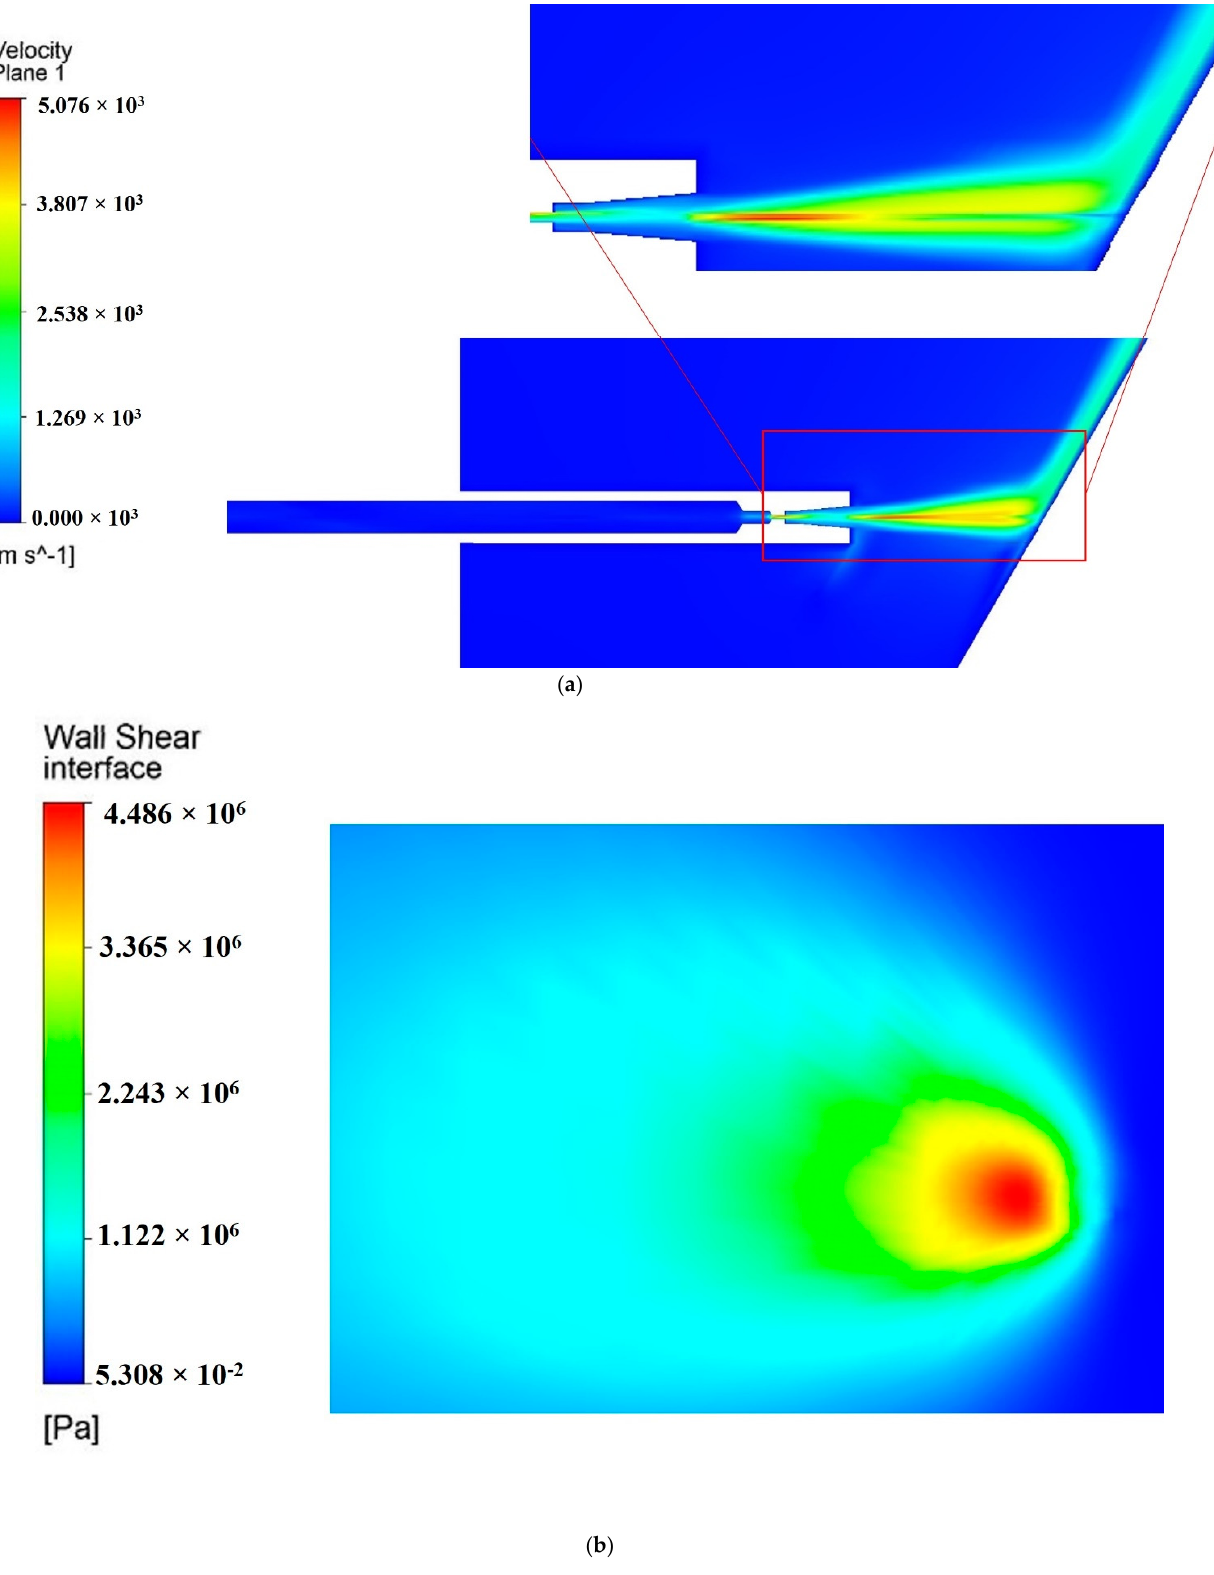
Figure 9. Contour of oblique impinging jet velocity and wall shear stress: ( a ) jet velocity; ( b ) wall shear stress.